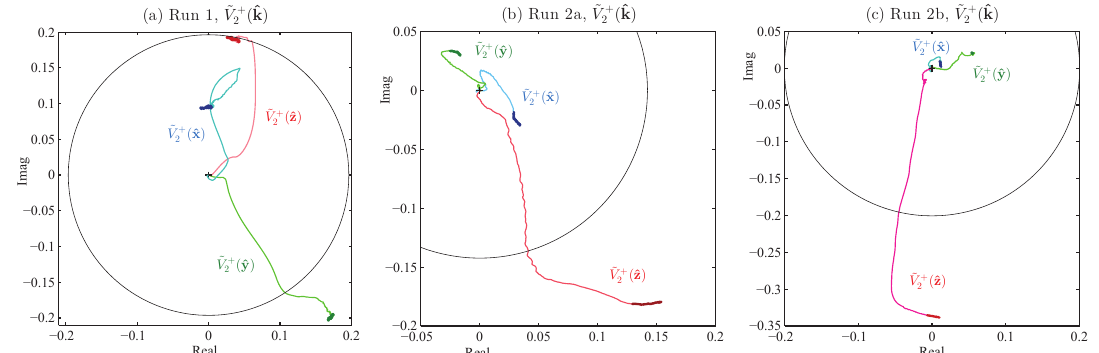
( ˆ x , t ) = ˜ b ( ˆ x , t ) , ˜ V ± ( ˆ y , t ) = ˜ b ( ˆ y , t ) 2 2 ± ±